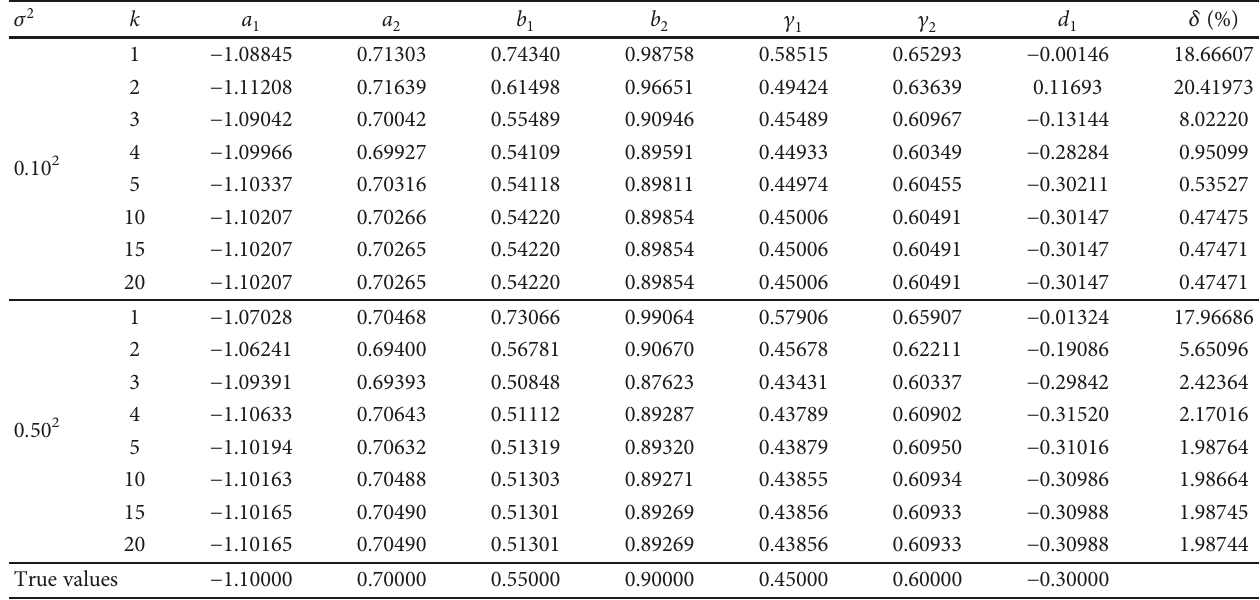
Table 1: The parameter estimates and errors of the E-NI